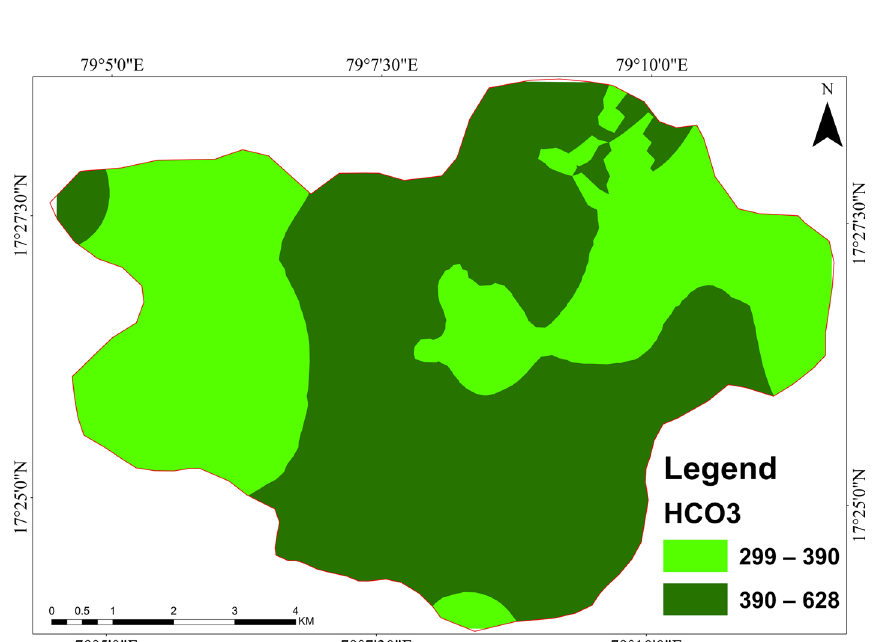
Fig. 10 Spatial distribution map of HCO 3− in Mothkur region, Telangana State, South